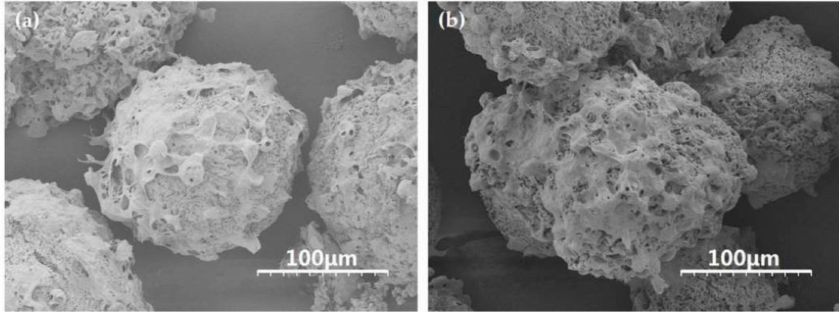
Figure 3. SEM images of L929 cells on the surface of ( a ) bFGF-unloaded and ( b ) bFGF-loaded SF microspheres after 5 days of culture. Scale bars: 100 μm.